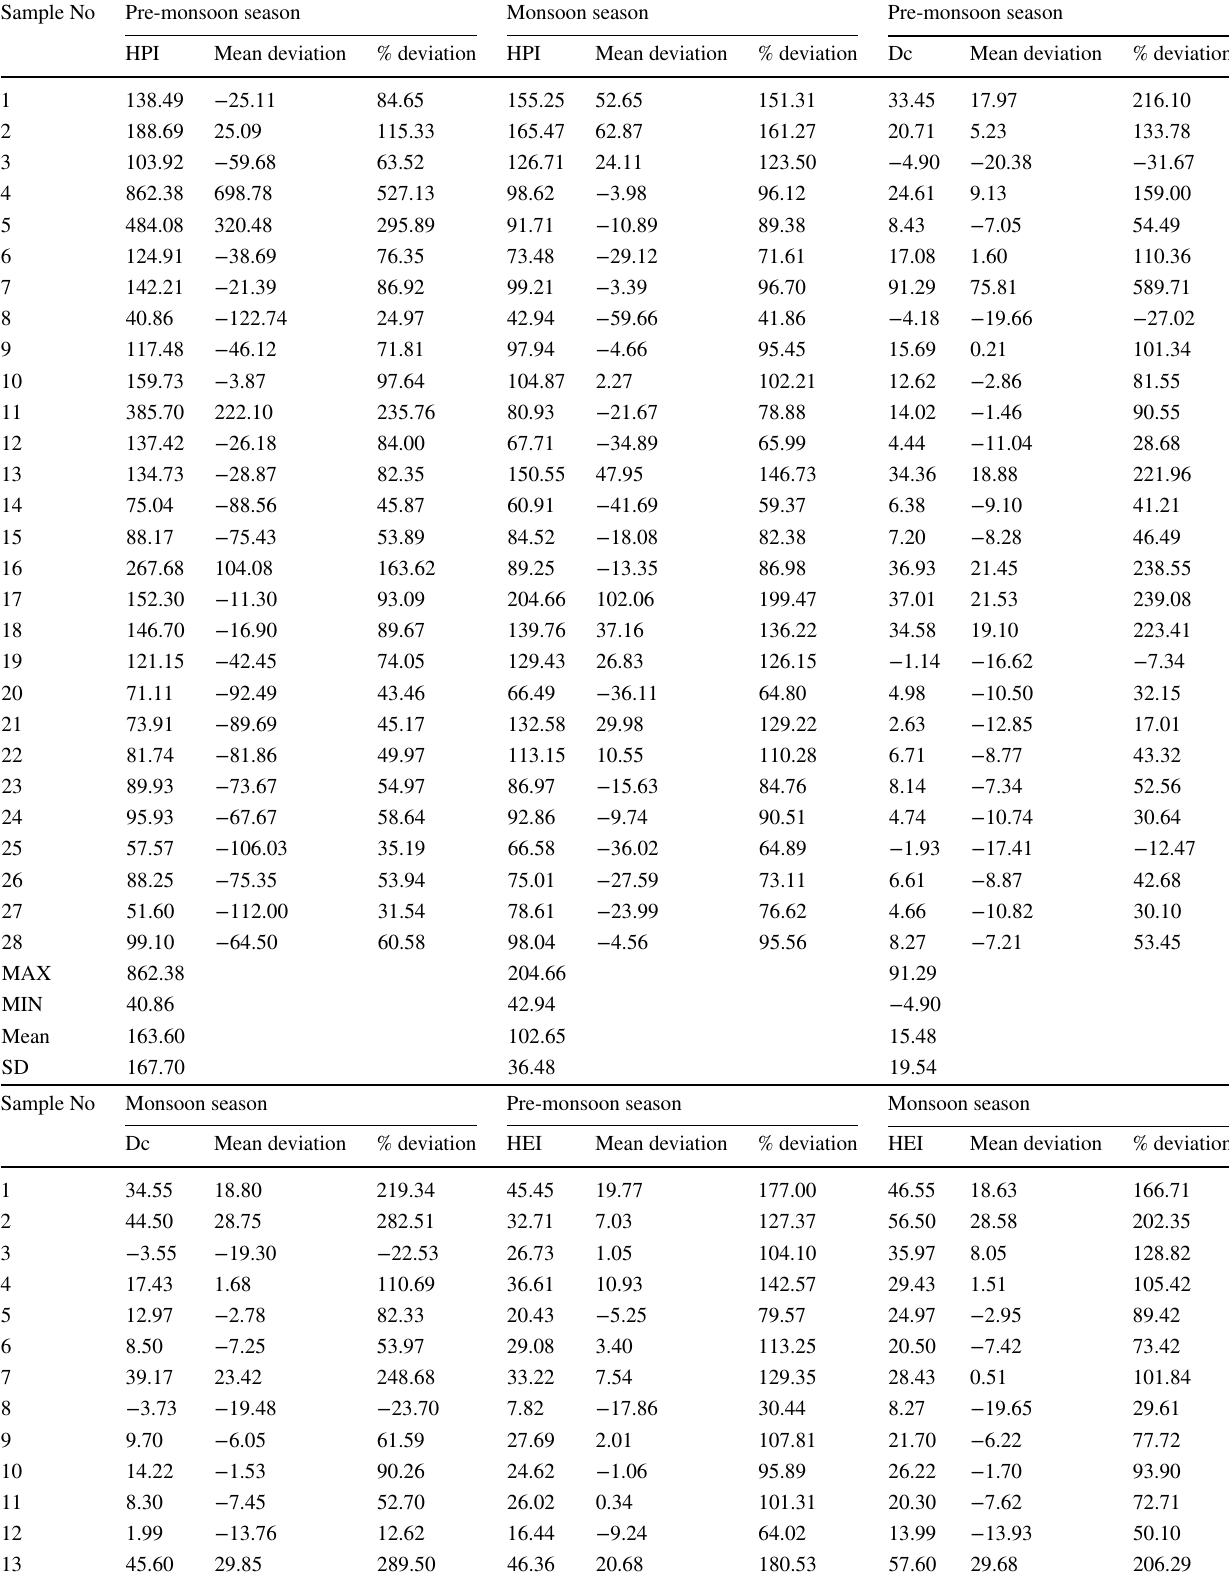
Table 5 Mean based reclassification methods based on HPI, Dc and HEI in premonsoon and monsoon season Sample